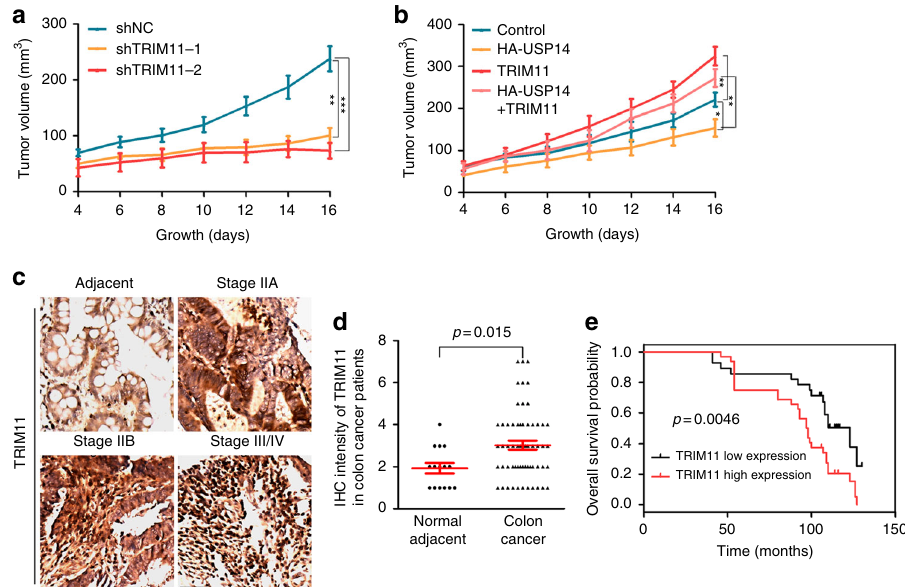
Fig. 8 Opposing roles of TRIM11 and USP14 in tumorigenesis. a , b HCT116 cells stably expressing the indicated shRNAs ( a ) or proteins ( b ) were subcutaneously injected into nude mice. Shown are average tumor volumes over time (mean± SEM, n = 4). * P < 0.05; ** P < 0.01; *** P < 0.001. c , d Representative pictures of IHC ( c ) and statistical data ( d ) of TRIM11 expression in different stages of clinical colon cancer and adjacent normal tissues. Scale bar, 50 μ m. P value was assessed using two-tailed Student ’ s t tests. e Kaplan – Meier analysis of cumulative survival probability of colon cancer subdivided by TRIM11 expression. The statistical signi fi cance ( P = 0.0046) was assessed using log-rank test according to colon cancer patients with low or high expression of TRIM11. TRIM11 low expression, n = 28; TRIM11 high expression, n =